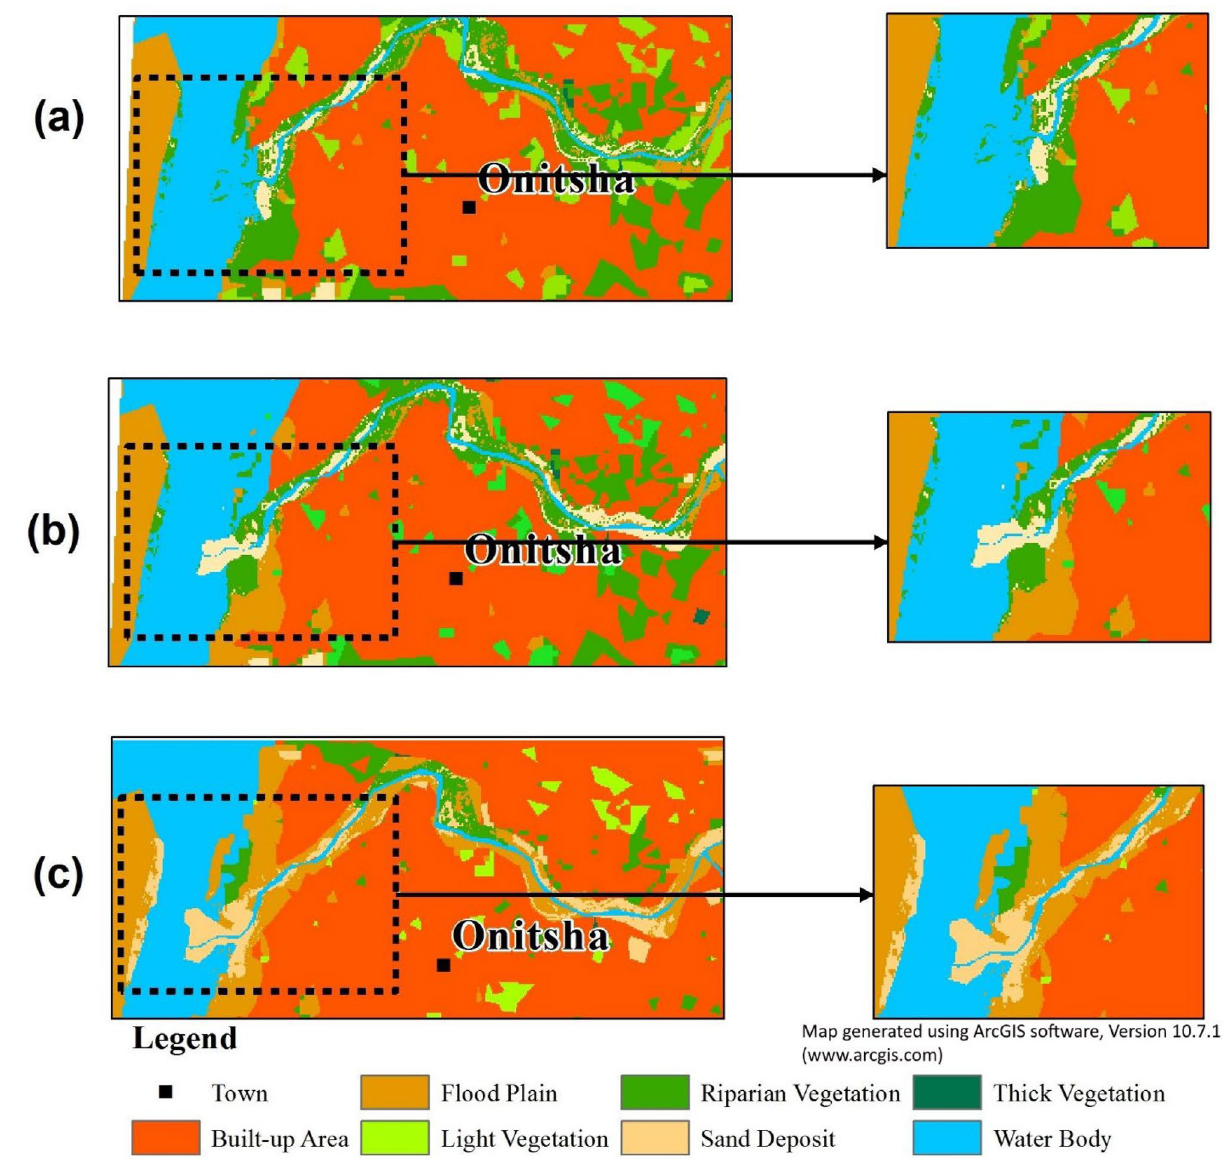
Figure 3. Trends of land use/land cover (LULC) change in Reach 3 area for ( a ) 2003 ( b ) 2016 and ( c ) 2019. By using an ArcGIS software (version 10.7.1), the LULC maps were obtained by producing a detailed subset of Fig. 2 ( Reach 3 area) to clearly examine the rates of bank erosion, channel widening and accretion under different land